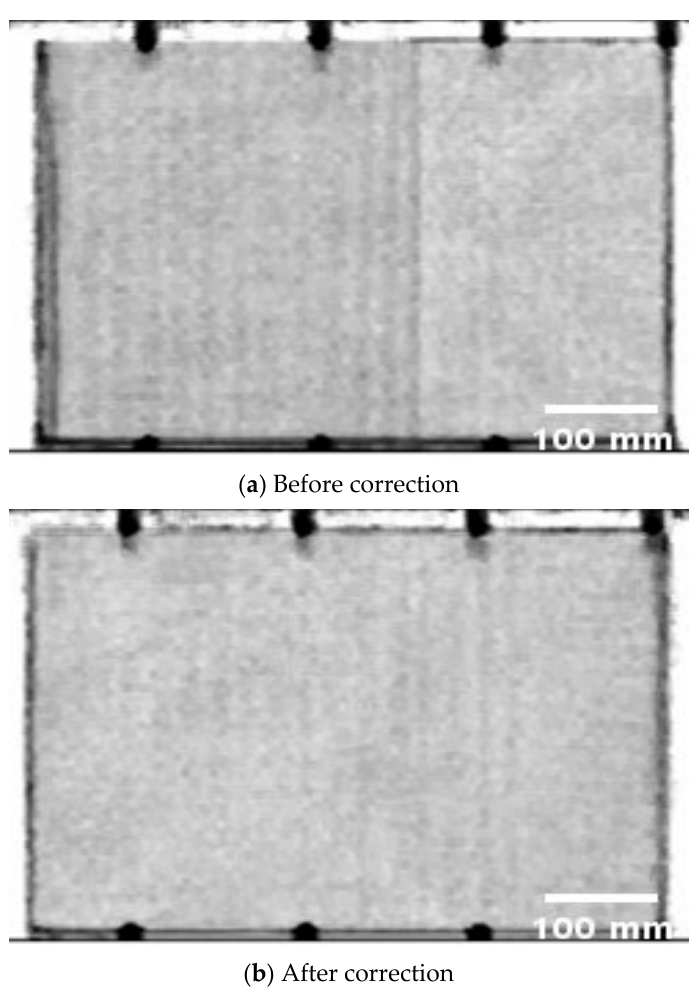
Figure 13. Ultrasonic images of the actual composite material specimen.